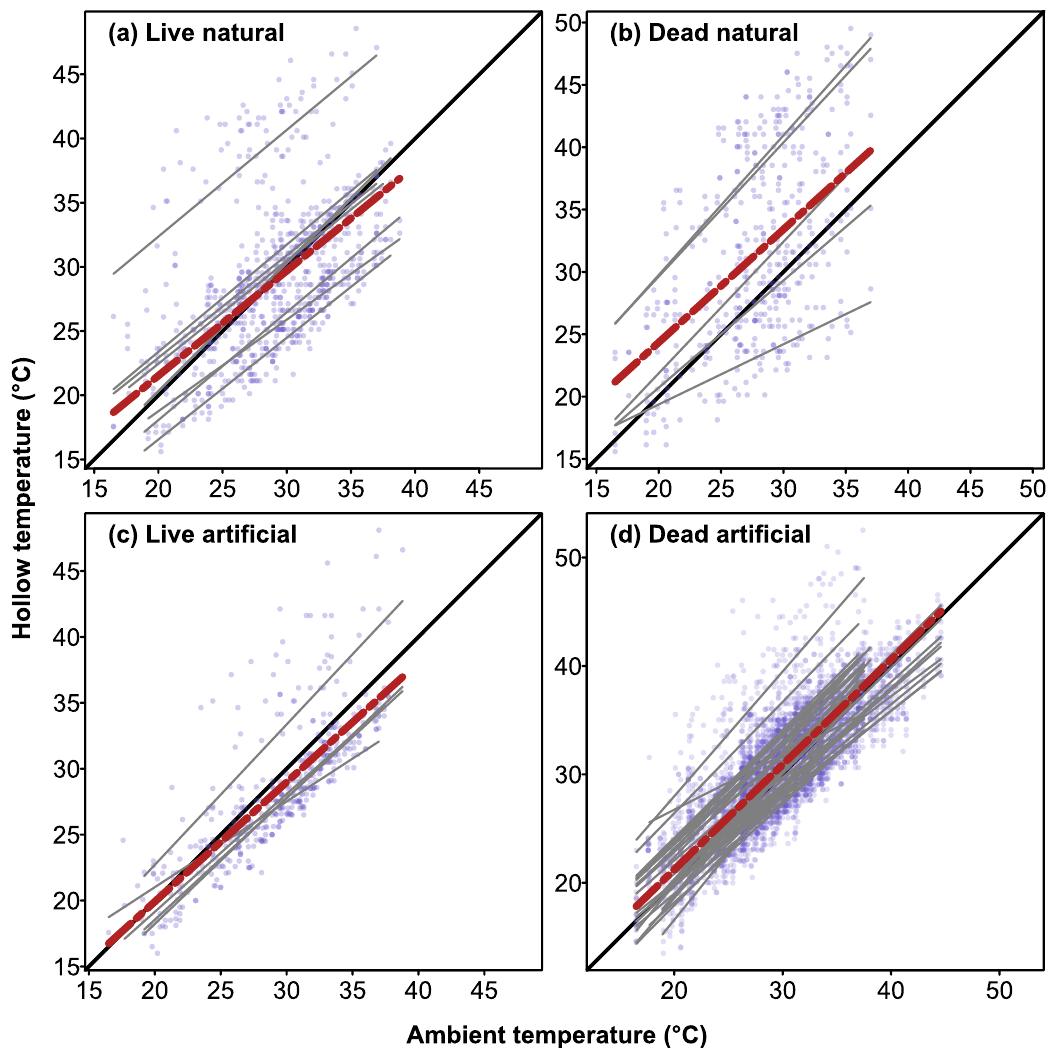
Figure 6. Linear regressions of relationship between maximum daily air temperature (recorded at the weather station nearest to the hollow) and maximum hollow temperature for natural hollows in live ( a ) and dead ( b ) trees, and artificial CHs in live ( c ) and dead ( d ) trees. Grey solid lines show linear fits for individual hollows, while black solid line indicates a 1:1 relationship between ambient temperature and hollow temperature. Lines below the 1:1 relationship indicate thermal buffering. Red dotted lines show lines of best fit for all hollows combined, while blue dots indicate data points for individual hollows.